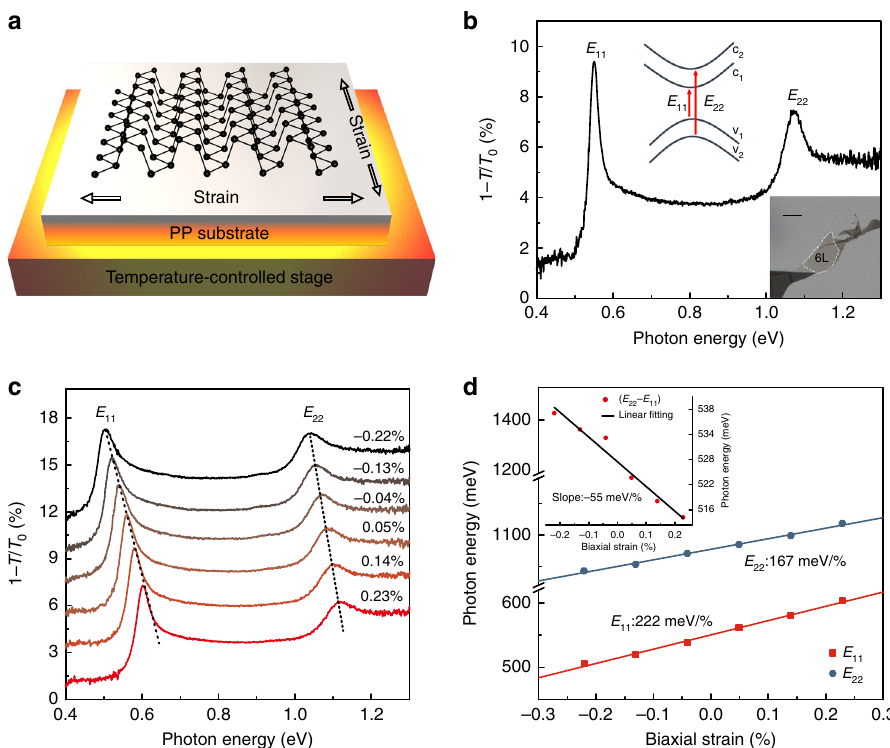
Fig. 1 Band structure engineering by biaxial strain. a Schematic illustration of the experiment setup used for applying in-plane biaxial strain by heating or cooling the PP substrate. b A typical IR extinction spectrum (1 − T / T 0 ) for a 6L BP on PP substrate under zero strain, with the incident light polarized along the AC direction. Top inset is a schematic illustration for optical transitions between different subbands. Bottom inset is an optical image of this 6L BP sample. Scale bar: 20 μ m. c IR extinction spectra (1 − T / T 0 ) for the 6L BP under varying biaxial tensile (>0) and compressive (<0) strains. For clarity, the spectra are vertically offset. Dashed lines are guides to the eye. d The E 11 and E 22 peak energies as a function of biaxial strain. The solid lines are linear fi ts to the data, which give shift rates for E 11 and E 22 of 222 and 167 meV/%, respectively. The inset shows ( E 22 − E 11 ) as a function of biaxial strain and the solid line is a linear fi t to the